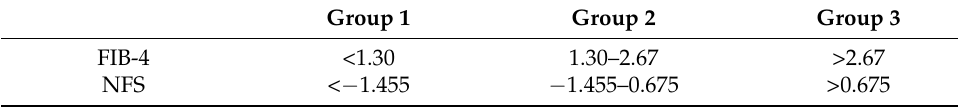
NFS: Nonalcoholic fatty liver disease (NAFLD) fibrosis